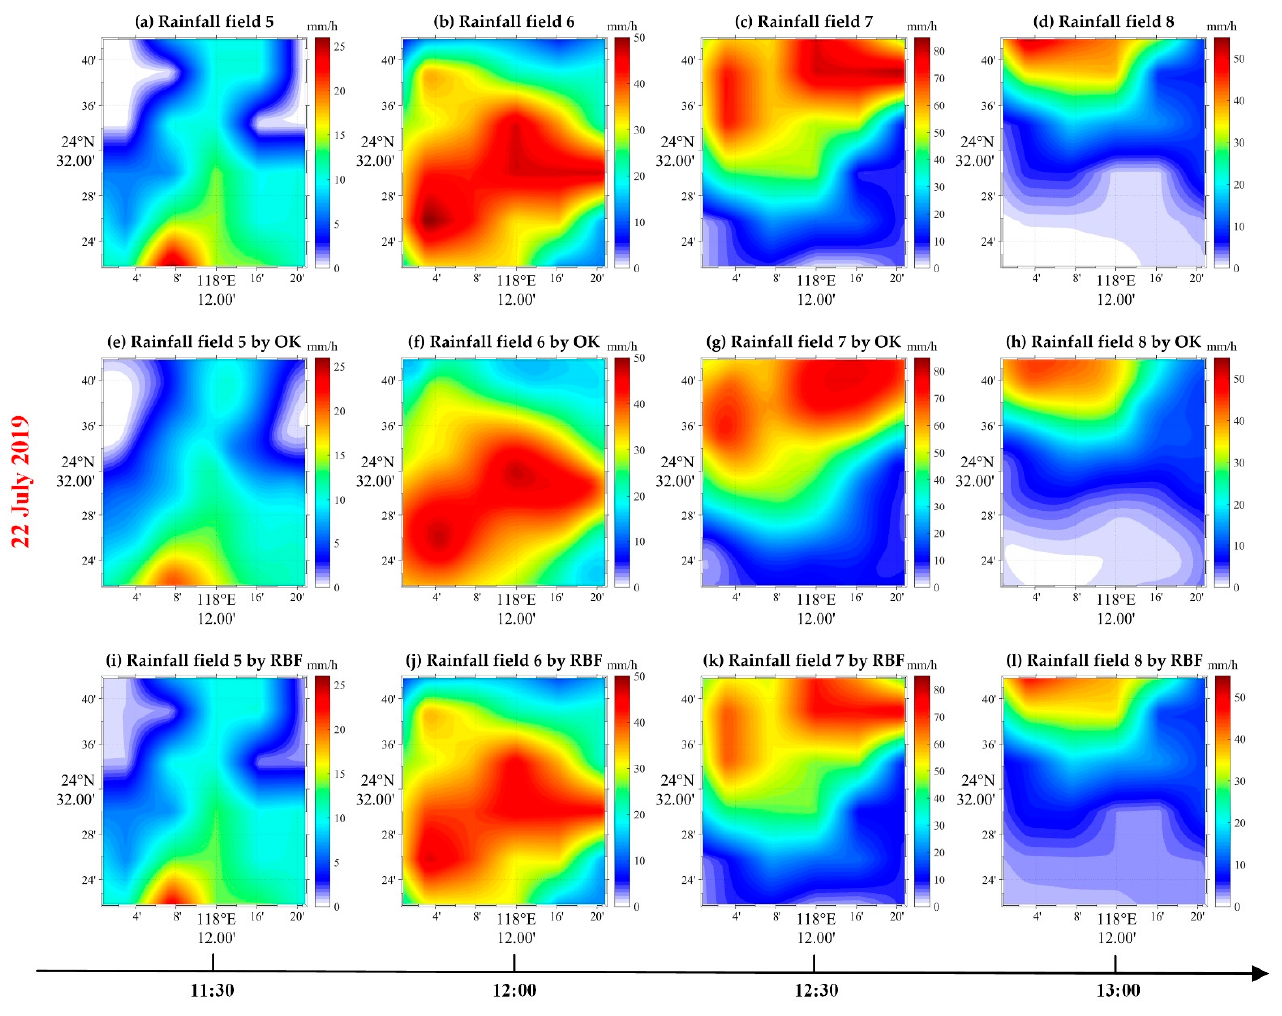
Figure 12. The results of retrieving convective rainfall event that occurred on 22 July 2019 by combining ESLs and HMLs. Rainfall field 5 to rainfall field 8 in ( a – d ) show the development of the convective rainfall with a high peak of rain rate, rapid development and fast movement of the rain cluster. ( e – h ) are the results of retrieving the convective rainfall from rainfall field 5 to rainfall field 8 by the OK algorithm, and ( i – l ) are the results of retrieving the convective rainfall from rainfall field 5 to rainfall field 8 by the RBF neural network. Table 4. The results of retrieving two different types of rainfall events by the joint network of ESLs and